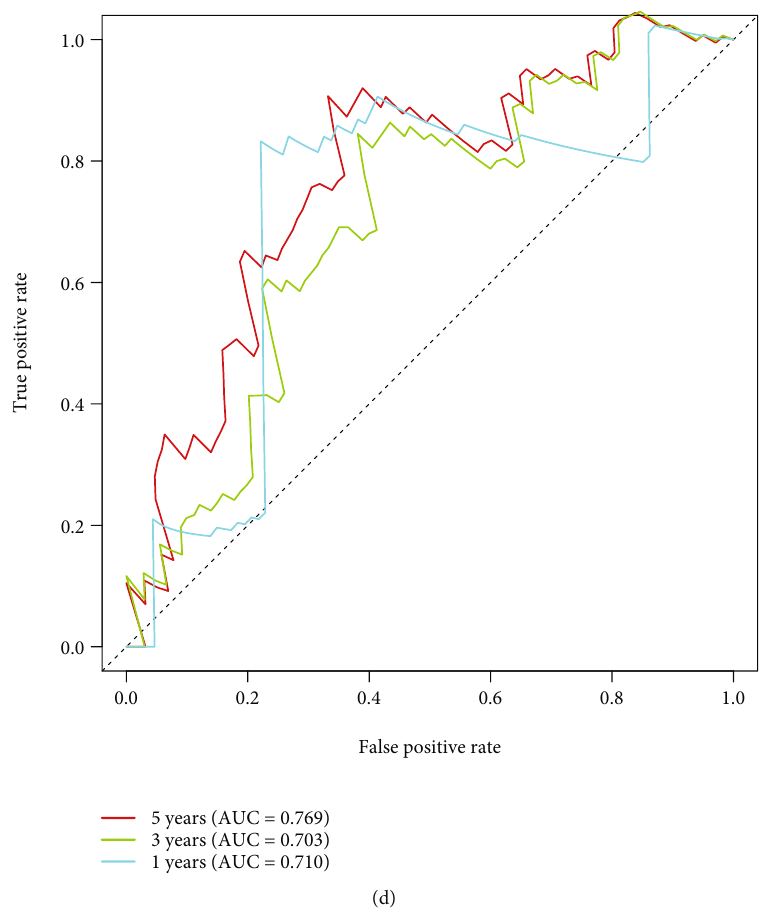
Figure 6: The prognostic value of the eight-ARG signature in the test set. (a) Distribution of risk score and patient survival status of cervical cancer. (b) Expression heat map of high-risk and low-risk groups. (c) The KM curve demonstrates that patients in the high-risk group had a poorer prognosis. (d) Time-dependent ROC curve analysis for survival prediction by the risk